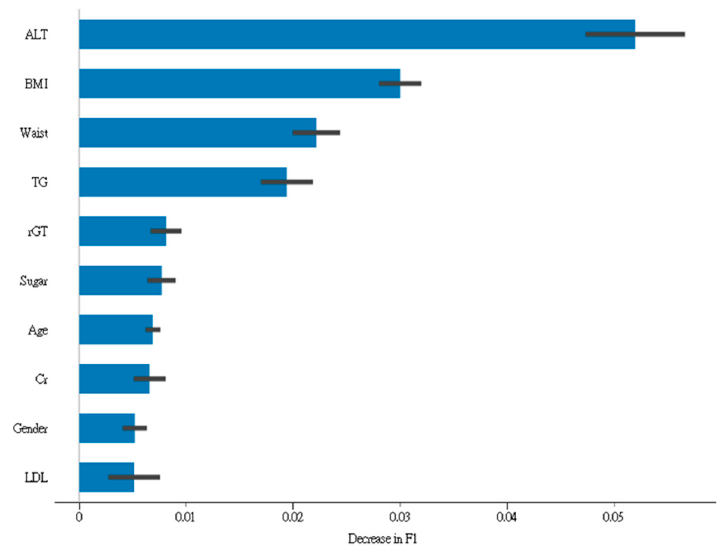
Figure 1. Top ten features of data contributing to the F1 score of the developed xgBoost model.